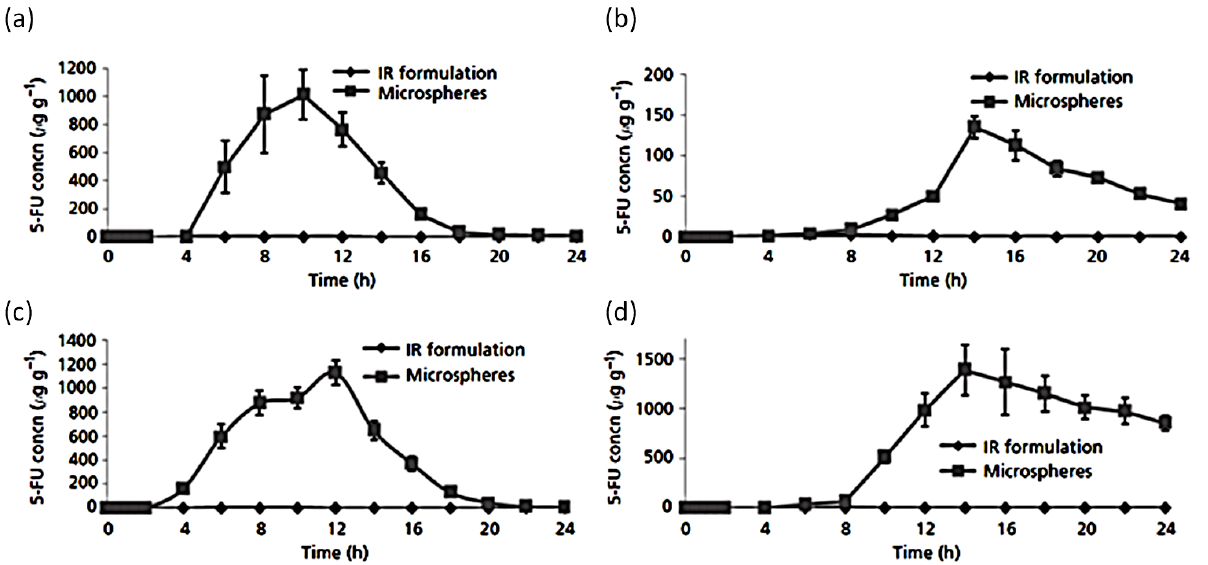
Figure 6. 5-FU concentrations in homogenates of caecum contents ( a ) caecum tissues ( b ) colonic contents ( c ) and colon tissues ( d ) after oral administration of colon-specific developed microspheres and immediate-release (IR) formulations of 5-FU. [85], reproduced with permission from Oxford Academic.